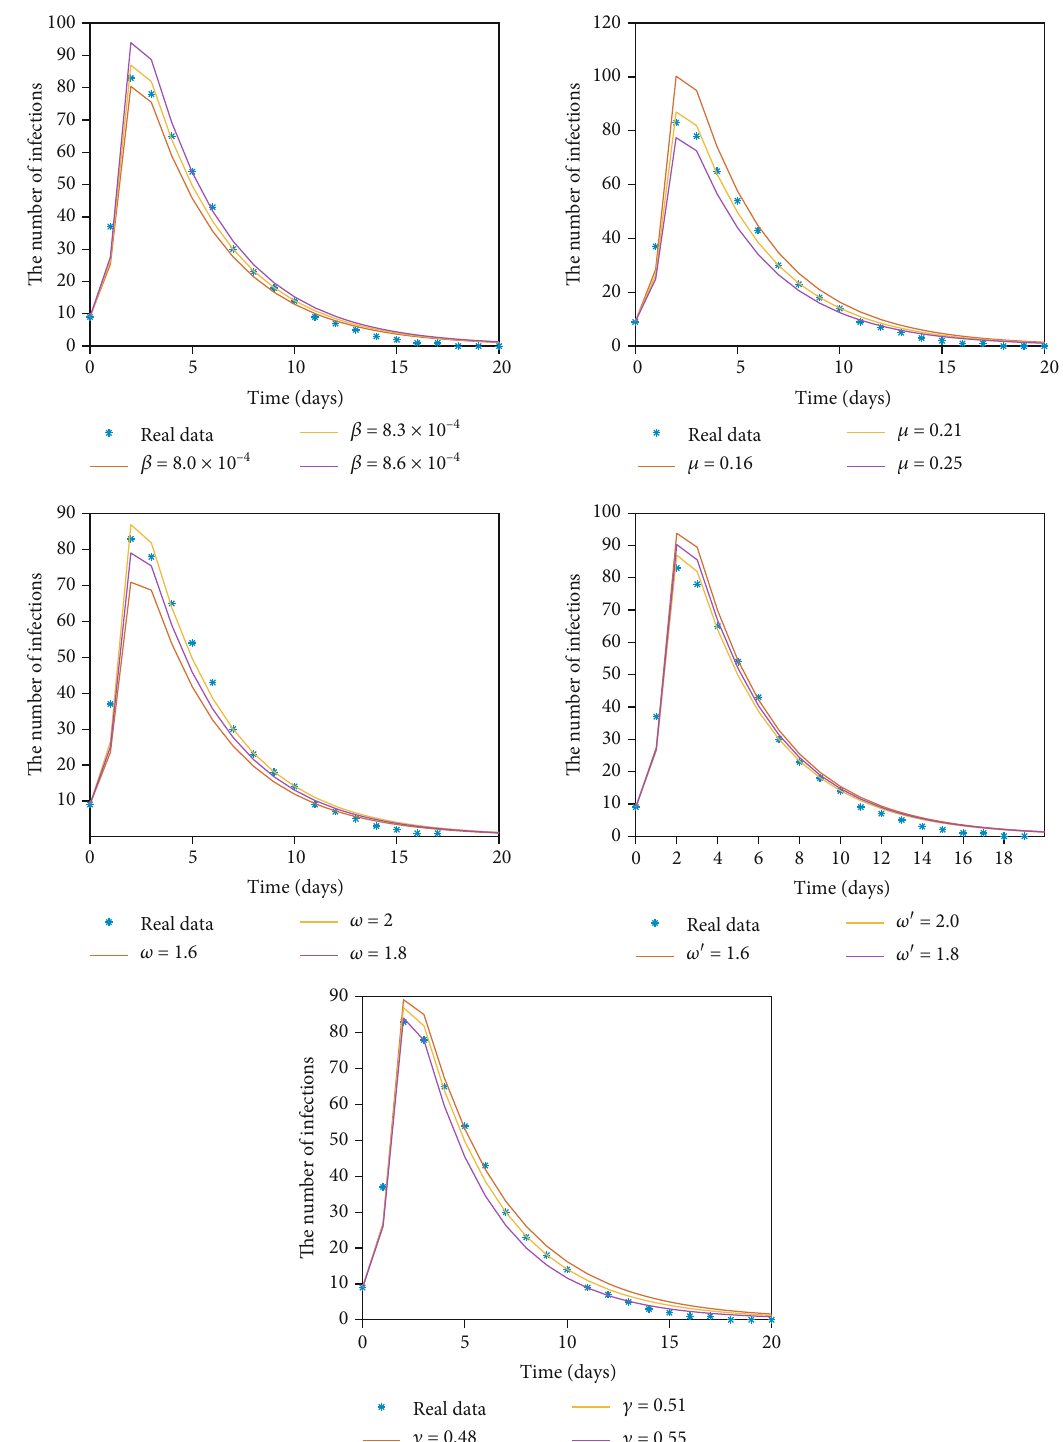
Figure 4: The in fl uences of β , μ , ω , ω ′ , γ on the quantity of infections I ð t Þ when the remaining parameters remain